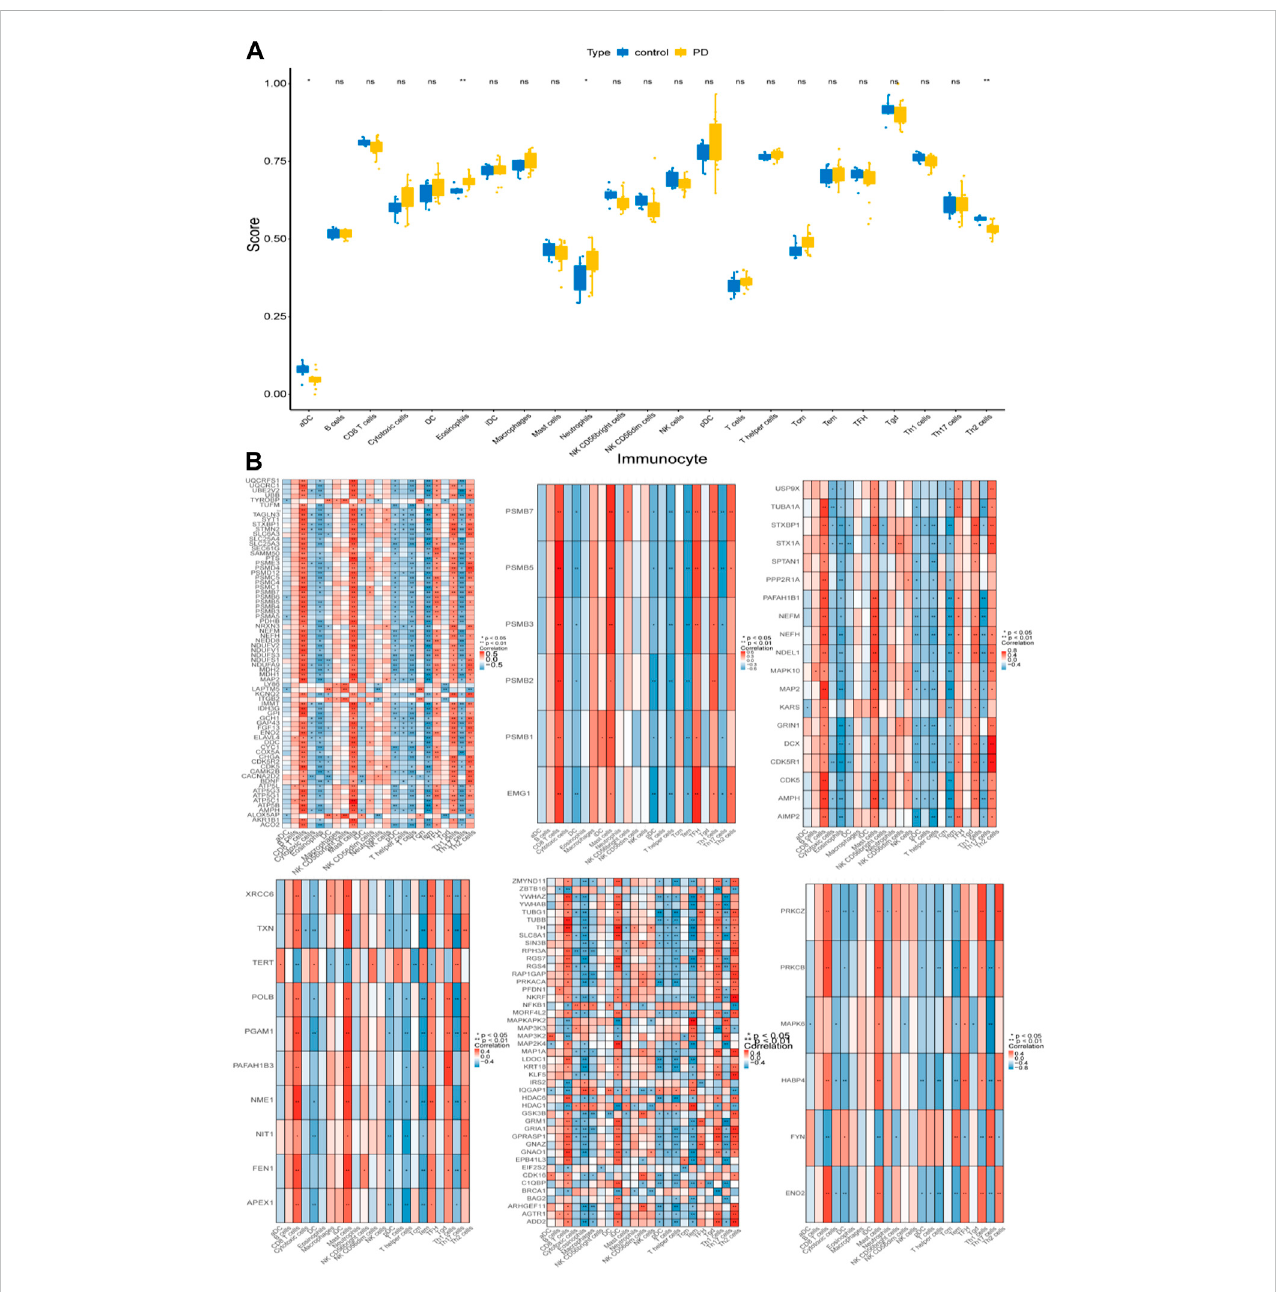
FIGURE 6 Immune cell in fi ltration analysis. (A) ssGSEA algorithm was performed to calculate the in fi ltration levels of 24 immune cell types in PD and normal samples. (B) The correlation heatmaps of 6 module genes with differential immune cells. * represented p < 0.05, ** indicated p < 0.01, ns represented no signi fi cant difference, red indicated positive correlation, blue indicated negative